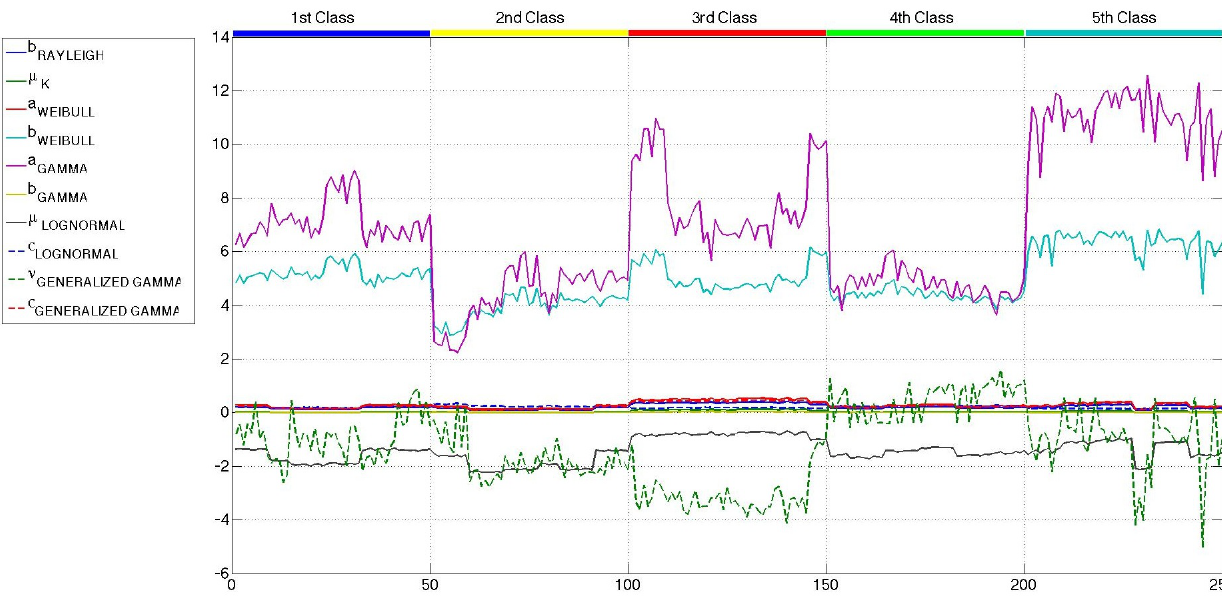
Figure 11. Selection of statistical parameters estimated from a reduced set of mean-shift-filtered patches. Fifty patches of each considered class are used for the estimation.